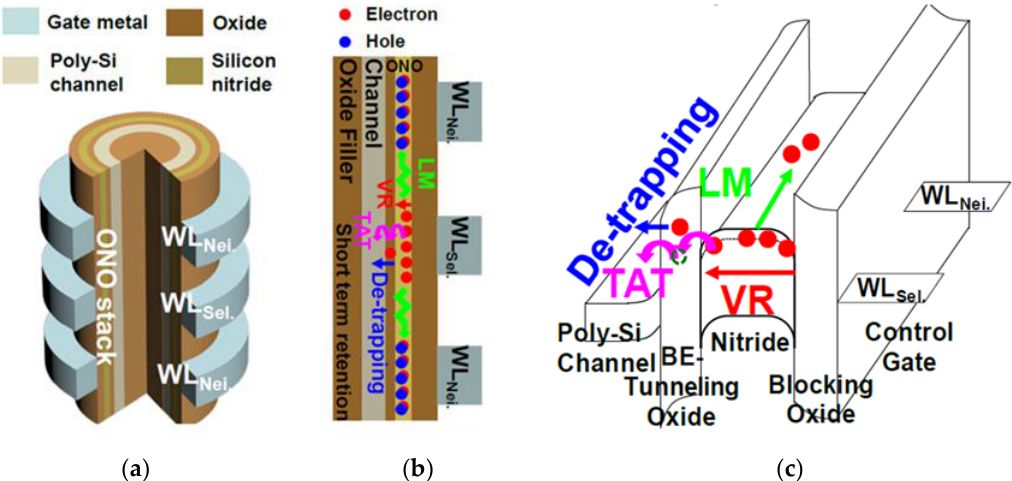
Figure 8. ( a ) The bird’s eye view and ( b ) cross-sectional view of 2D NAND with charge-trap cells. ( c ) Energy band diagram schematic for short-term retention and possible retention mechanisms. Reprinted with permission from ref. [40], copyright 2020 IEEE.